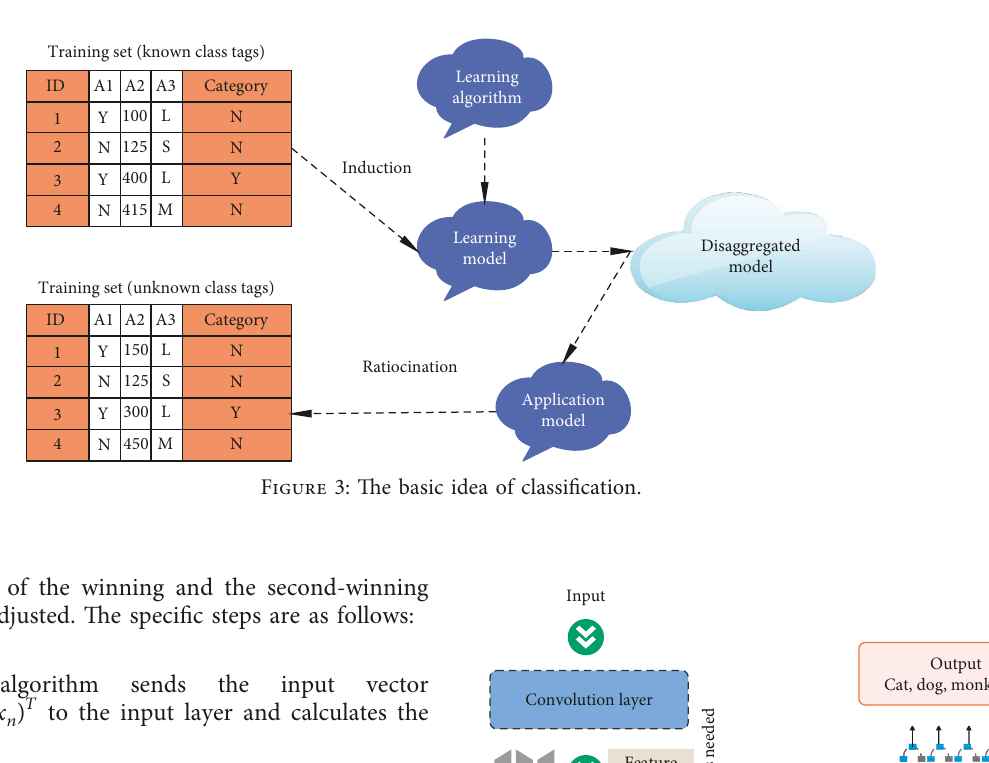
Figure 2: LVQ neural network structure.